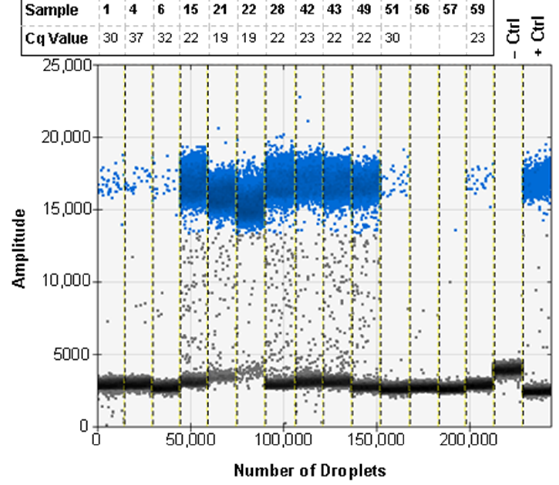
Figure 6. The ddPCR assay using EvaGreen can be used to detect H. armigera DNA in ratios of 1 H. armigera leg: 50 H. zea legs with low quality H. armigera specimens. The corresponding Cq value rounded to the nearest full number is shown for each of the samples. Sample names and Cq values correspond to Table 5. Blank entries indicate a false negative real ‐ time PCR result. Positive droplets are shown in blue, and negative droplets are shown in grey.